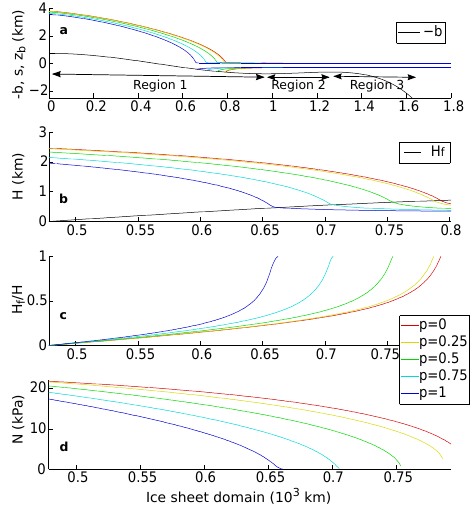
Figure 2. Dependence of ice geometry and effective pressure on p , as in Fig. 1 but with the polynomial bed as in Schoof (2007b), containing two stable regions (1 and 3) and an unstable region